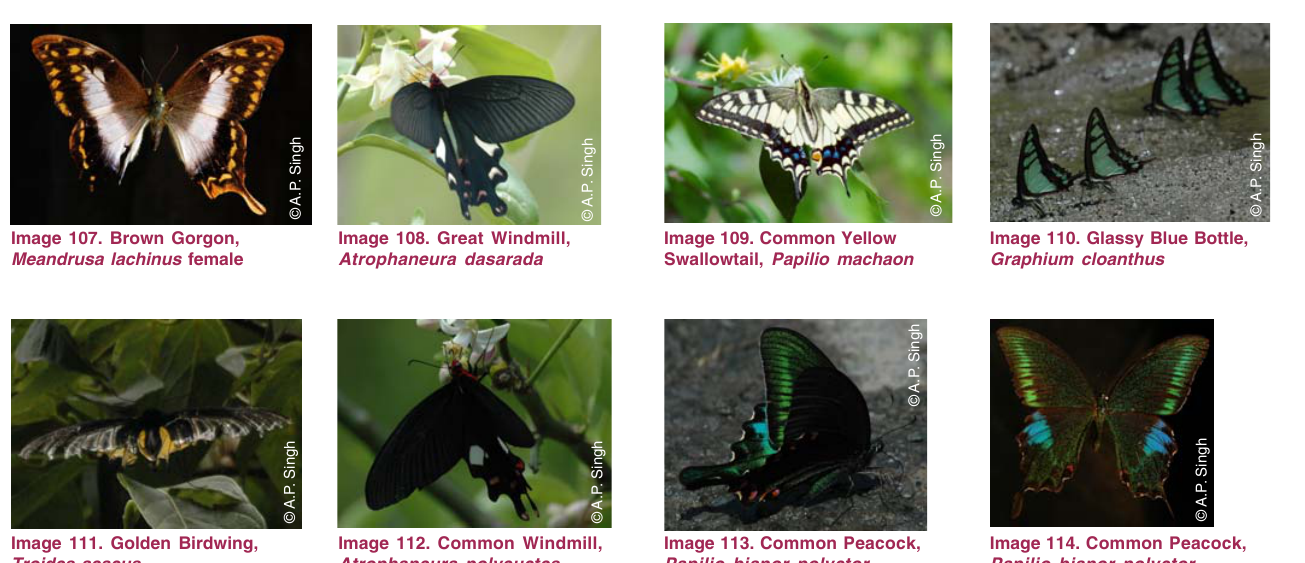
Image 104. Viened Labyrinth, Neope pulaha (under)